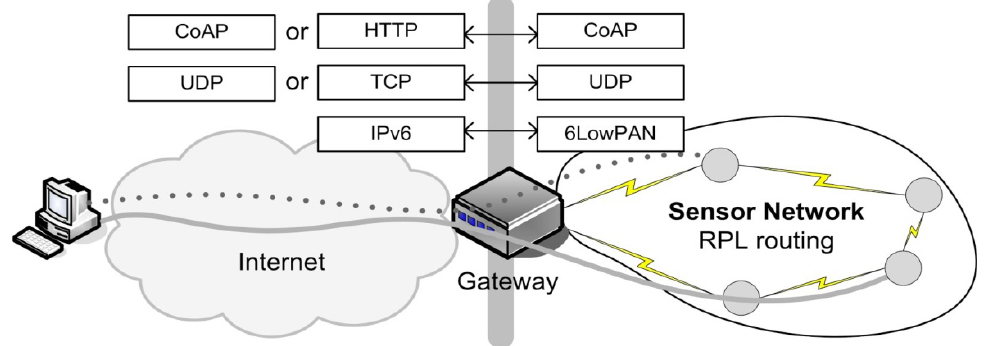
Figure 2. Internet protocols are extended to the sensor networks. The Gateway translates between the two standardized protocol